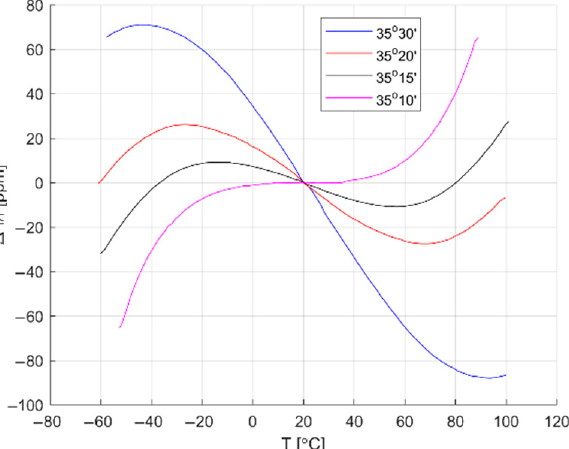
Figure 1. AT-cut quartz crystal thermal characteristics for different cut angles